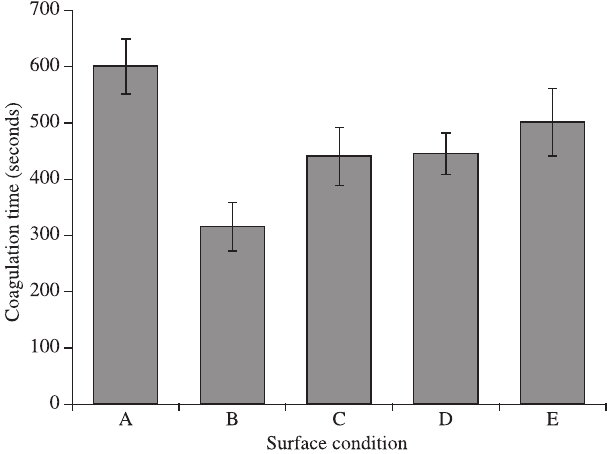
Figure 4. Average coagulation times of blood samples freshly collected (A); in contact with untreated glass slides (B); exposed to SF